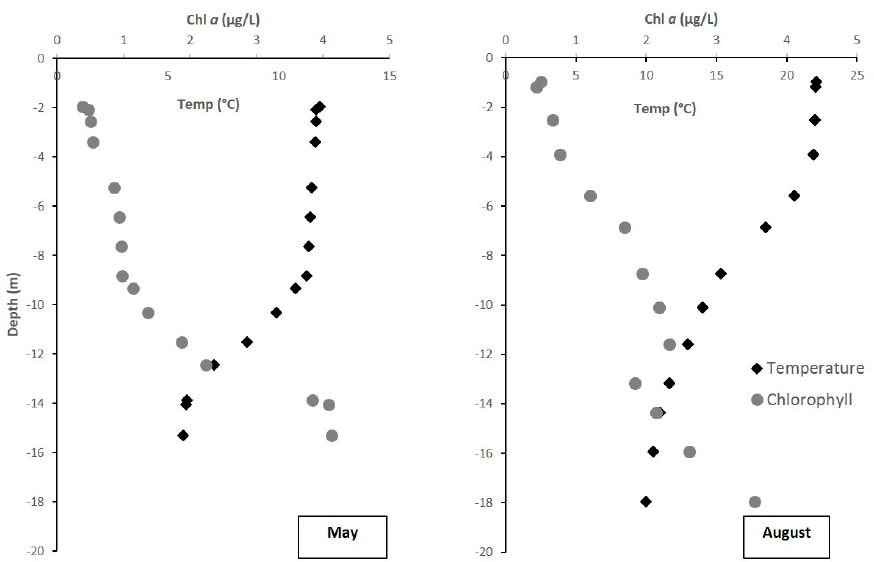
Figure 11. Vertical profiles of temperature ( ◦ C) and chlorophyll a ( µ g.L − 1 ) at the NEMAC farming site in the two seasons. Table 5. Experimental conditions (mean ± s.d.), as mussel traits and seston characteristics at approximately 15-m